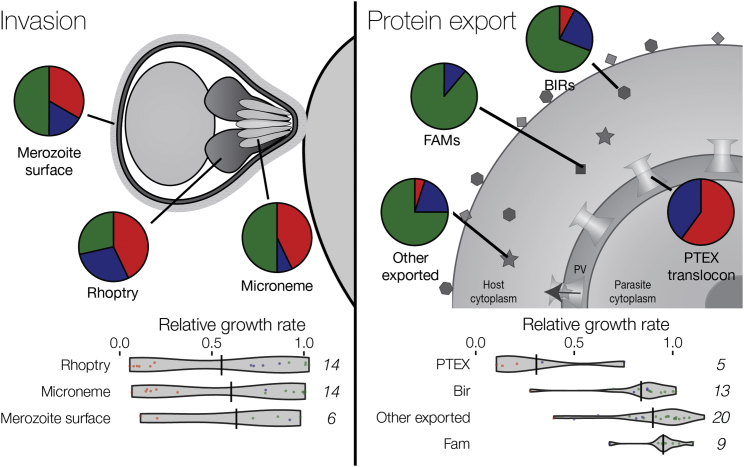
Reduced Essentiality among Genes Involved in Direct Interactions with the HostPhenotype distributions for secreted and surface proteins of the invasive merozoite and for proteins exported from the asexual intraerythrocytic parasite are shown as pie charts using the same colors as in Figure 2. Gene numbers in each category are next to violin plots showing RGR. Enrichment in dispensable genes is significant for bir (p < 0.02), fam, and “other exported” (both p < 0.01).See also Table S3.